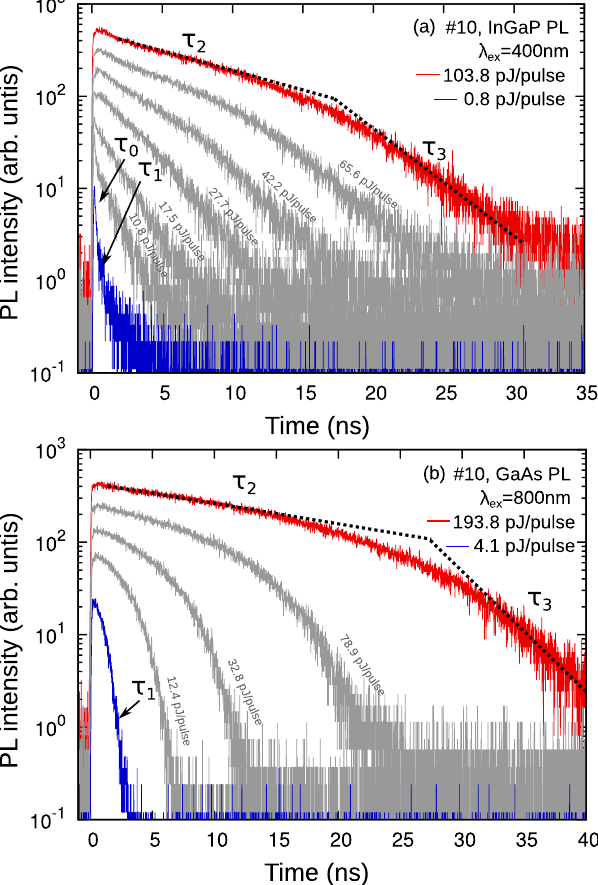
Figure 3. Power dependence of PL decays from ( a ) InGaP and ( b ) GaAs subcell of sample #10, before